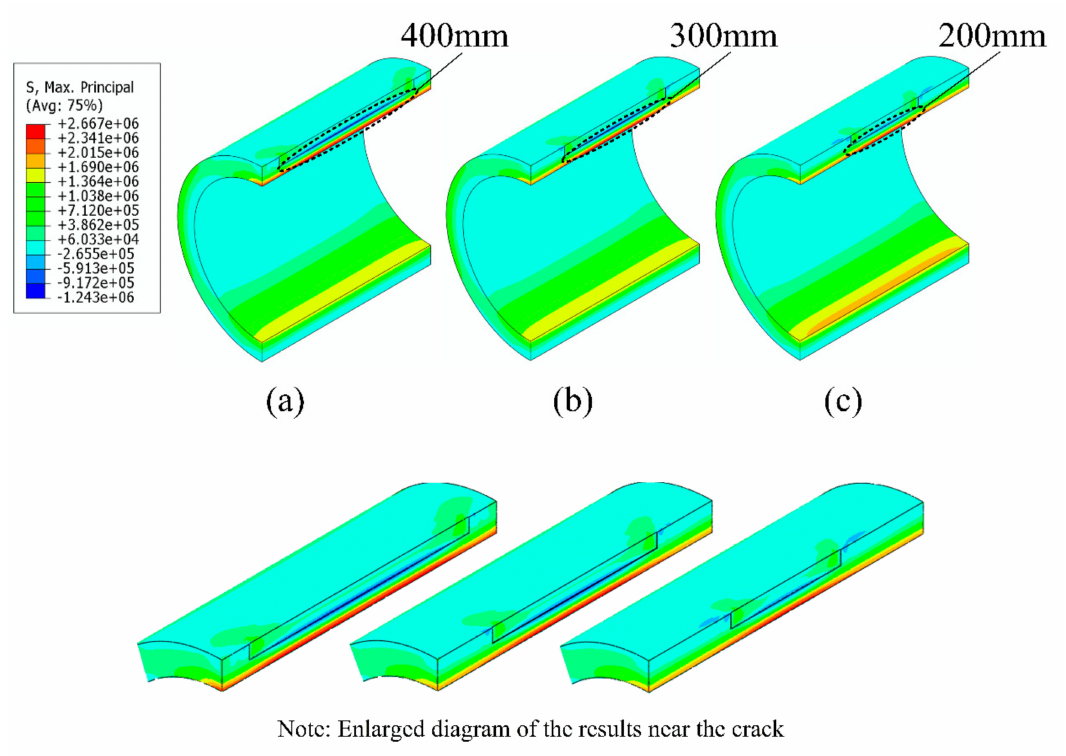
Figure 15. Nephogram of the maximum principal stress of the pipes containing cracks with di ff erent lengths: ( a ) 400 mm, ( b ) 300 mm, and ( c ) 200 mm.